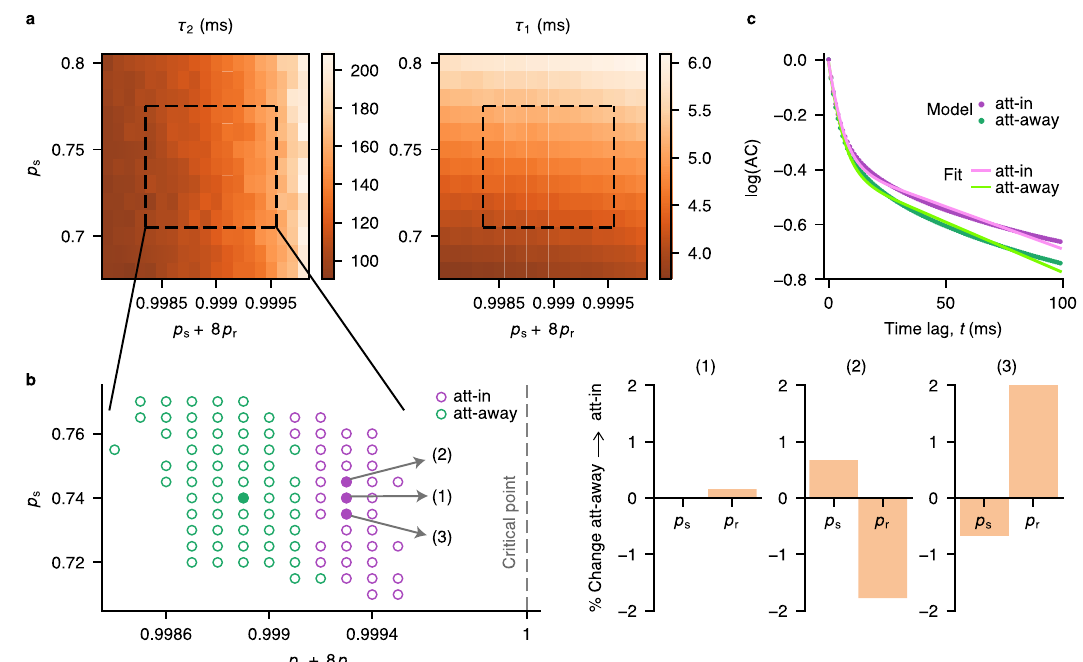
Fig. 7 | Modulation of the slow timescale during attention is mediated by an increase in the ef fi cacy of network interactions. a Effect of connectivity para- metersonlocaltimescalesinthemodel.Thefasttimescale( τ 1 ,right)mainlydepends on the self-excitation probability ( p s ), whereas the slow timescale ( τ 2 , left) depends onboththeself-excitation( p s )andrecurrenthorizontalinteractions( p r ).Thedashed rectangles indicate the range of parameters reproducing V4 timescales (mean± s.e.m.ofMAPestimates,Methods). b Theslowtimescaleincreaseswiththenetwork excitability ( p s +8 p r , left panel). Green and magenta dots indicate the parameters reproducing attend-away (att-away) and attend-in (att-in) timescales, respectively.